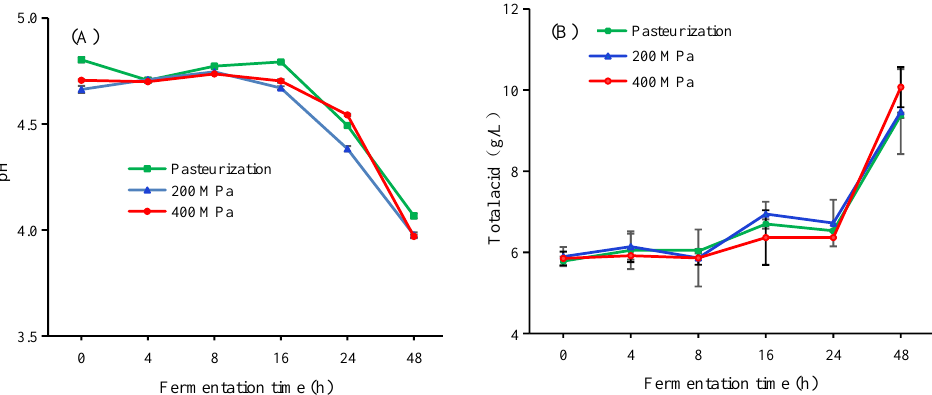
Figure 2. Changes in pH value ( A ) and total acid ( B ) of apple juice with different treatments during fermentation. HHP treatments (200 or 400 MPa, 10 min); pasteurization (85 °C, 15 min). Experiments were performed in triplicate; vertical bars indicate ± SD ( p < 0.05).